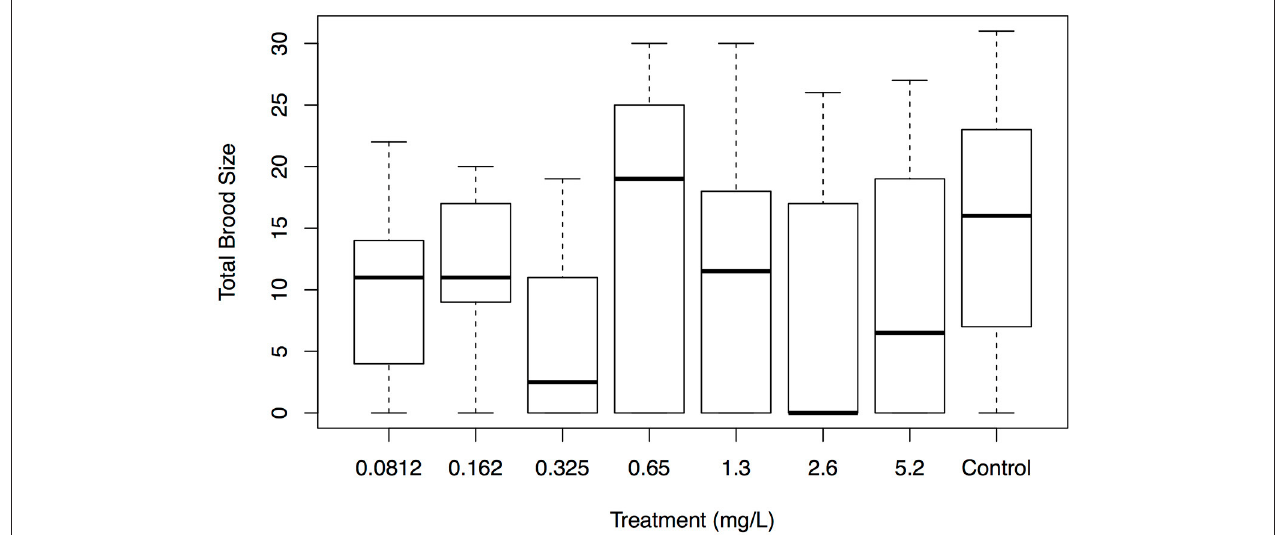
FIGURE 1 | Total brood size of C. dubia exposed to different concentrations of ethylbenzene and the negative control. The box and whisker plot displays a five-number summary of the total brood size data for each treatment with ethylbenzene from lowest to highest concentration (mg/L) with the negative control on the right. The bar in the middle of each box represents the median, the top, and bottom of the box the lower and upper quartiles (25 and 75%) and the whiskers the minimum and maximum values.